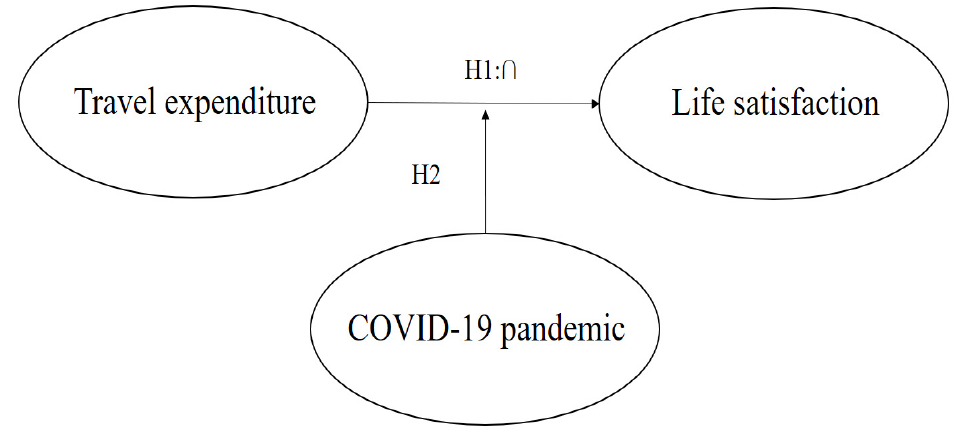
Figure 1. Research Figure 1. Research model.